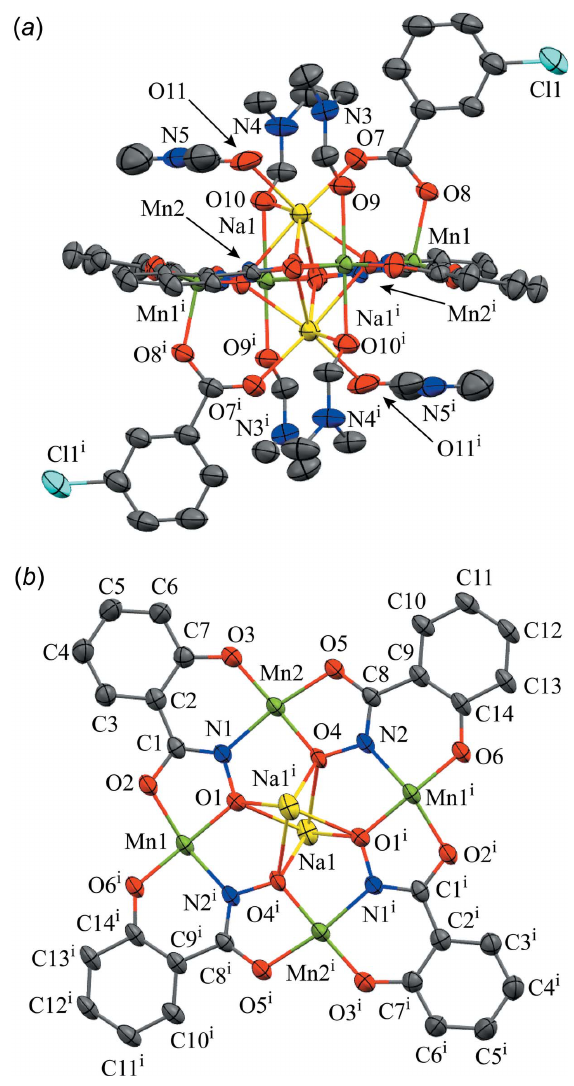
Figure 1 The single-crystal X-ray structure of Na 2 (3-chlorobenzoate) 2 [12- MC Mn(III)N(shi) -4](DMF) 6 , 1 , with displacement ellipsoids at the 50% probability level [symmetry code: (i) (cid:3) x + 1, (cid:3) y + 1, (cid:3) z + 1]. ( a ) side view with only the metal atoms and heteroatoms of the axial ligands labelled for clarity and ( b ) top view with the axial ligand atoms omitted for clarity. In addition, hydrogen atoms and disorder have been omitted for clarity. Color scheme: green – Mn, yellow – sodium, red – oxygen, dark blue – nitrogen, gray – carbon, and light blue – chlorine. All figures were generated with the program Mercury (Macrae et al. , 2020).